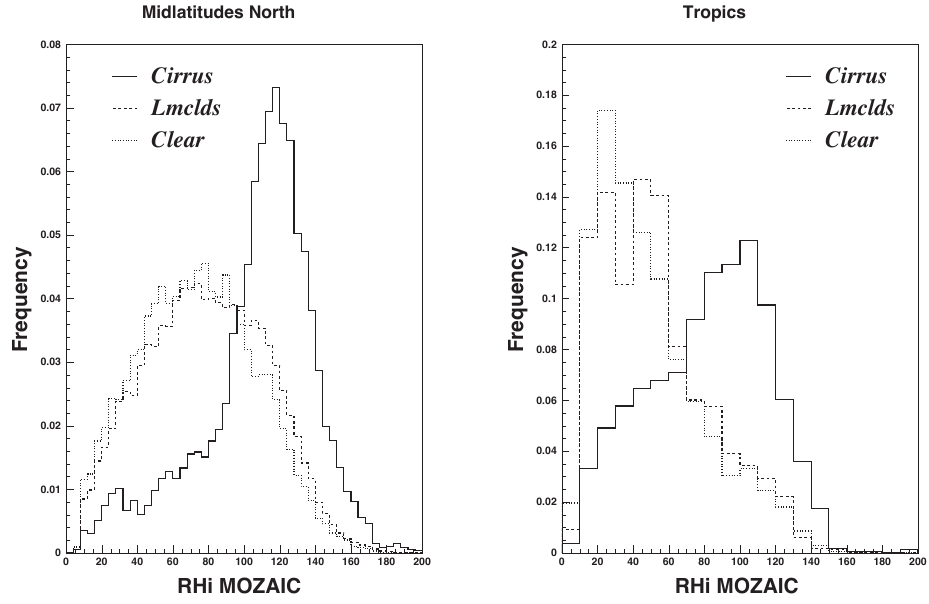
Fig. 4. Distributions of relative humidity seen by MOZAIC RHi M for three classes of AIRS cloud properties in two latitude bands: Northern Hemisphere midlatitudes (40–60 ◦ , left) and tropics (20 ◦ N–20 ◦ S, right). For lmclds and clear situations RHi M is all measurements between 200 and 300hPa, for cirrus situations measurements are taken at pressures close to the cloud pressure so that | p M − p cld | < 50hPa. The binning for the tropics is less resolved due to the smaller sample size in the